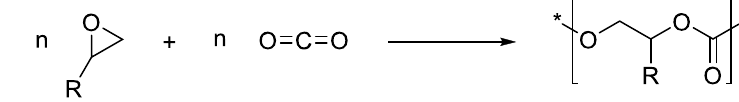
Fig. 4. Catalyzed copolymerization of CO 2 and epoxides yielding polycarbonates.